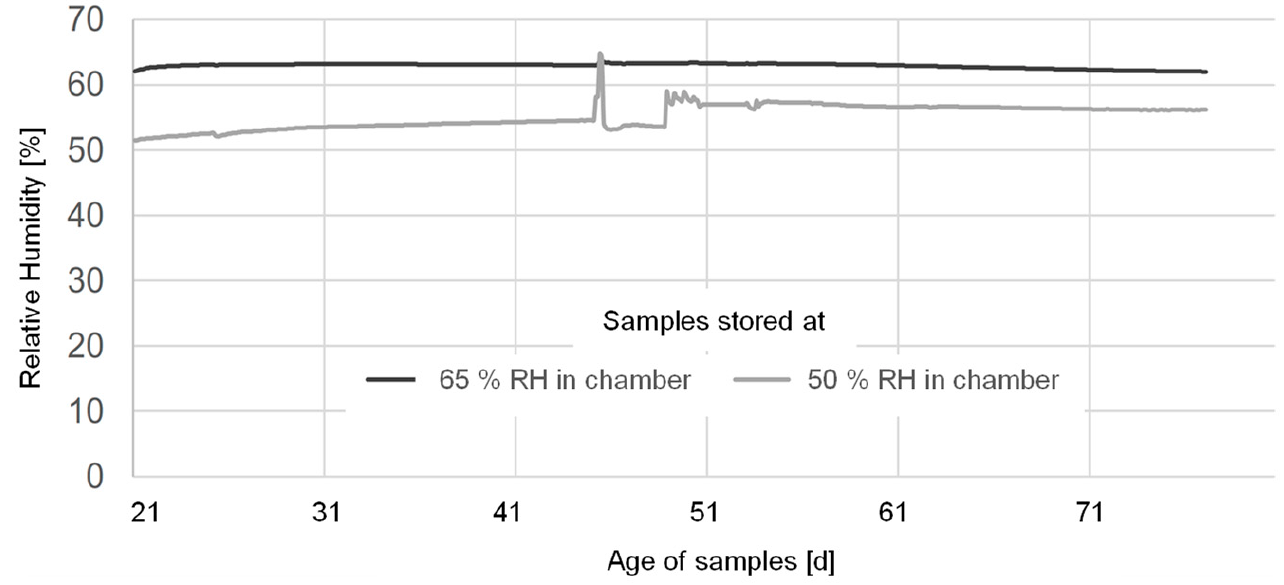
Figure 3. Internal relative humidity during CO 2 -free storage at 20 °C and 50% and 65% RH, respec- tively.